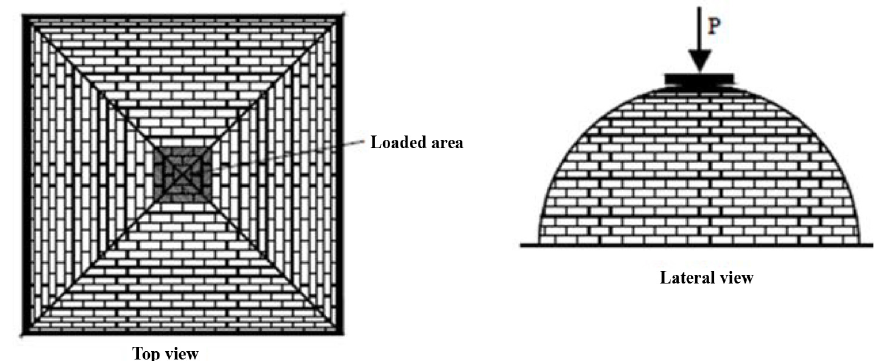
Figure 4. (a) Initial 3D- triangulation of the thrust surface; (b) fi nal solution of the trust surface (cid:3) red regions = area external to extrados; blue regions = area external to